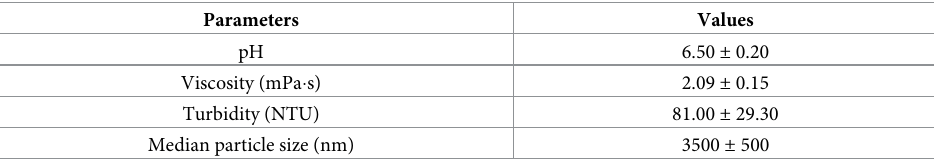
Table 2. Properties of simulated fracturing